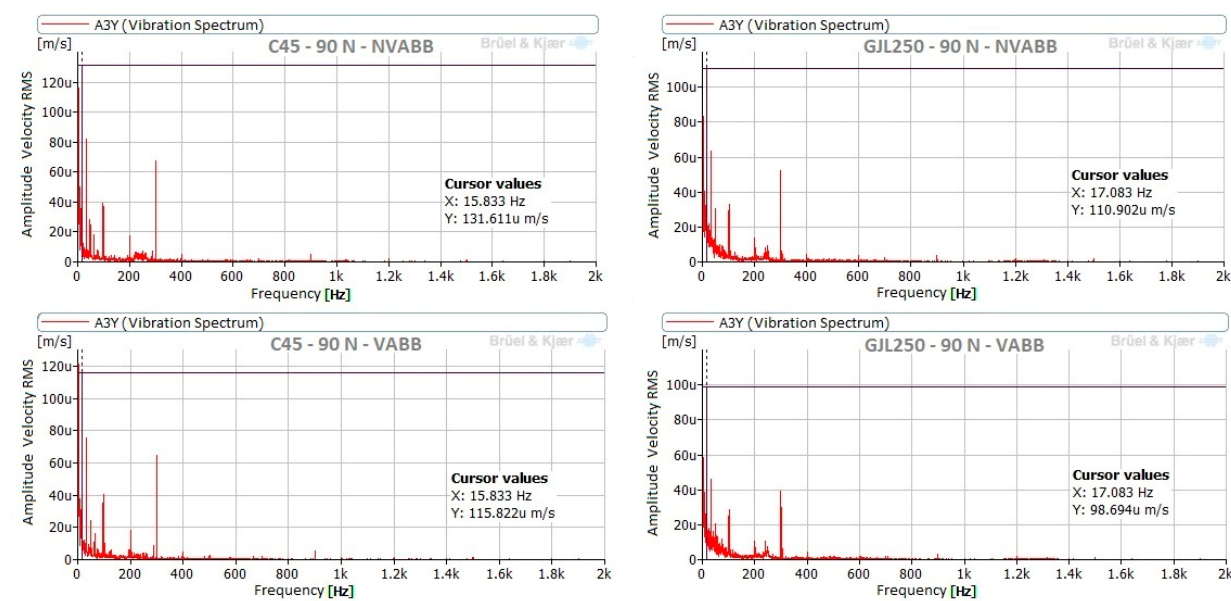
Figure 9. Comparison of spectra of both materials, using VABB and NVABB, measured at point P3, in Y (vertical) direction, and with a burnishing force of 90 N.